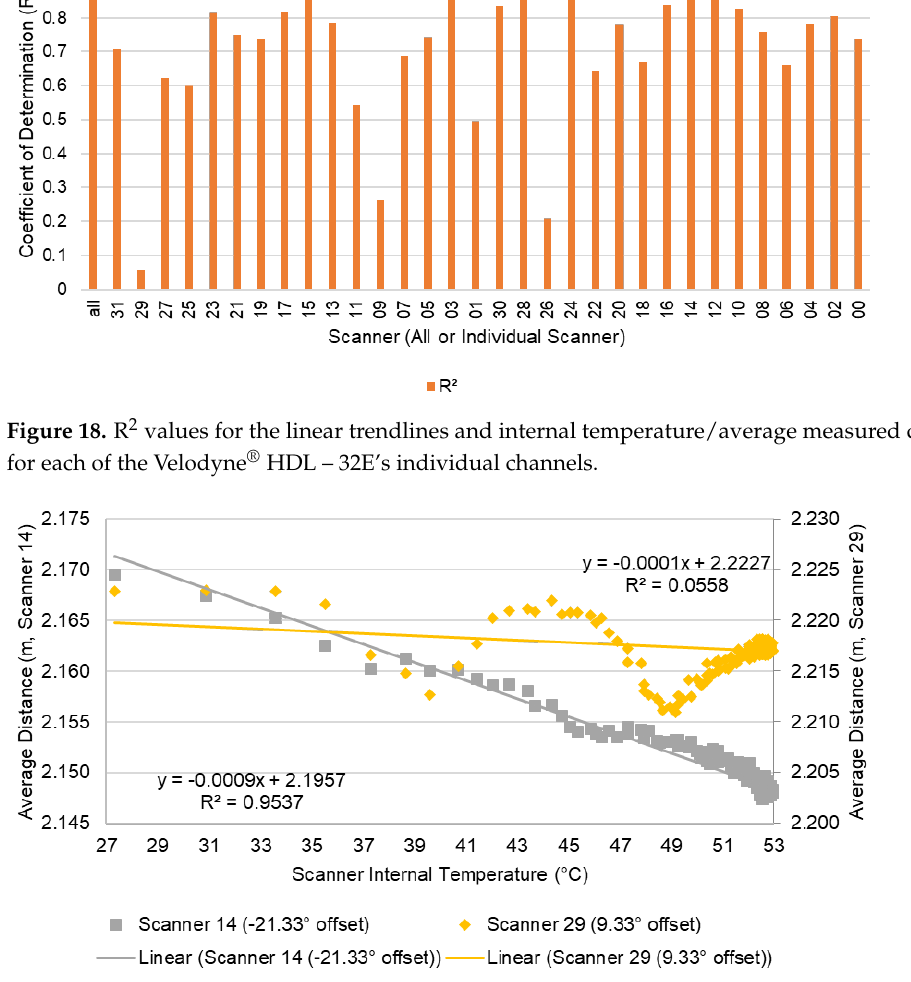
Figure 19. Linear relationship and correlation between Velodyne ® HDL – 32E internal temperature and average measured distances for the individual channels with the highest (channel 14) and lowest (channel 29) R 2 through the duration of indoor experiments. Equation for linear line of best fit and corresponding R 2 values are shown on the